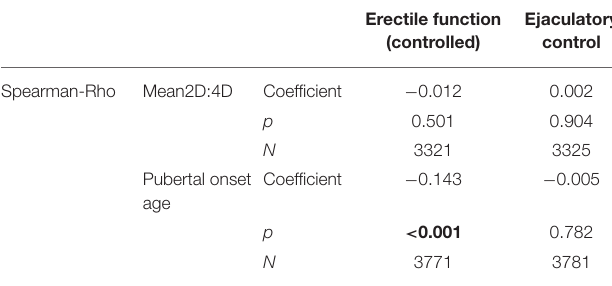
TABLE 3 | Prenatal testosterone markers and sexual functions.